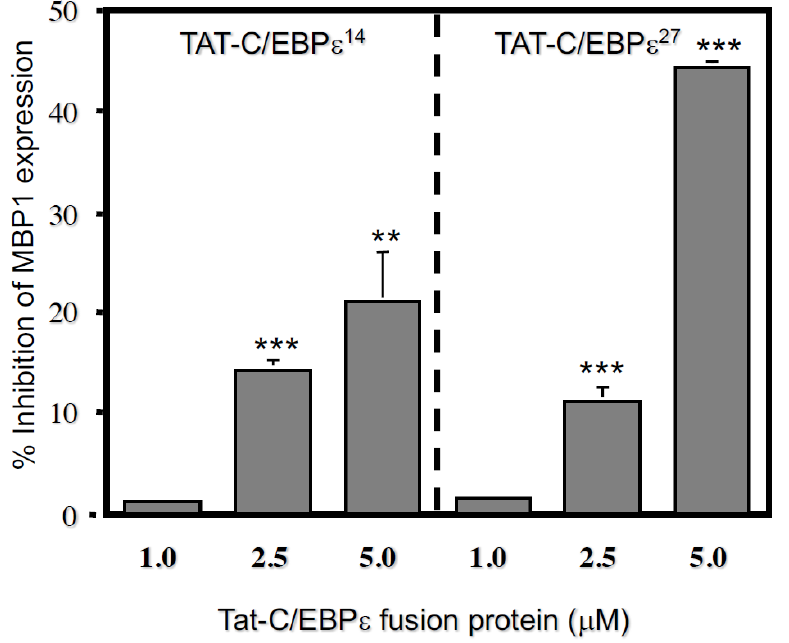
Figure 4. TAT-C/EBP ε 27 and TAT-C/EBP ε 14 inhibit endogenous MBP1 gene expression when trans- duced into AML14.3D10 eosinophil myelocytes. AML14.3D10 eosinophil myelocytes were transduced for 24 h with TAT-C/EBP ε 14 , TAT-C/EBP ε 27 , and TAT-GFP as control at equimolar concentra- tions. Two doses of the TAT-fusion proteins were given to cumulative final concentrations of 1.0, 2.5 and 5 μ M over 24 h. Cells were harvested at 24 h, total RNA extracted, and used for quantitative Taqman™ Re al Time RT-PCR assessment of steady state levels of MBP1 mRNA. Samples were an- alyzed for both MBP1 and GAPDH genes and compared to standard curves for each mRNA pre- pared from non-transduced AML14.3D10 cells analyzed under the same conditions except for the addition of the TAT-fusion proteins. The ratio of MBP1/GAPDH was determined for each sample, normalized to the value obtained for the TAT-GFP control transduced cells, and the results plotted as the mean (±SD) percent (%) inhibition of MBP1 mRNA expression compared to the TAT-GFP transduced control cells used for normalization of non-specific effects at the identical doses used for TAT-C/EBP ε 27 and TAT-C/EBP ε 14 . In comparison to the TAT-GFP control, TAT-C/EBP ε 27 and TAT- C/EBP ε 14 inhibited MBP1 mRNA transcription by ~45% and ~22%, respectively. Representative re- sults from 2 independent experiments are shown. ** p < 0.01, *** p < 0.001 compared to 1 μ M. 2.3. Repression Domains of C/EBP ε 27 Attenuate GATA-1 Transcriptional Activity: Both the Unique C/EBP ε 27 N-Terminus (RD27) and RDI Domains Inhibit GATA-1 Activity To map the repressor domain(s) in the C/EBP ε 27 isoform responsible for its potent antagonism of GATA-1 transcriptional activity, we generated a series of deletion and fu- sion mutation constructs in the C/EBP ε 27 expression vector. Figure 5 illustrates the con- served functional domains for the wild type isoforms of C/EBP ε 32 , C/EBP ε 27 , C/EBP ε 14 and the mutants of C/EBP ε 32 and C/EBP ε 27 generated for this purpose. Design of the mutant C/EBP ε proteins was based on previously published work on the murine C/EBP ε 32 ortholog (20,32) and the human C/EBP ε isoforms [1,2]. Results for co-transactivation as- says of the MBP1-P2 promoter with GATA-1 combined with the wild type C/EBP ε 32 , C/EBP ε 27 , C/EBP ε 14 expression vectors, and the deletion mutants of the C/EBP ε 27 isoform, are shown in Figure 5. These analyses include a fusion protein of C/EBP ε 32 (C/EBP ε φ 32 ) in which the unique N-terminal 68 amino acids of C/EBP ε 27 are fused to the N-terminus of C/EBP ε 32 . In the absence of GATA-1, none of the three wild type isoforms of C/EBP ε or deletion mutants of C/EBP ε 27 showed any significant transactivating or inhibitory poten- tial for the MBP1-P2 promoter, confirming our prior report [11]. In contrast, wild type C/EBP ε 27 potently inhibited GATA-1 transactivation of this promoter, whereas the C/EBP ε 14 isoform, nature’s own deletion of the unique N -terminus RD27, RDI, and most